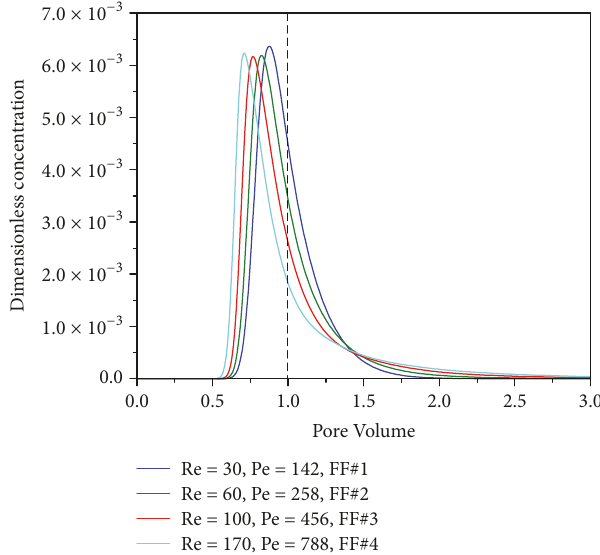
Figure 3: Breakthrough curves of compound A for the nonreaction transport under the different flow fields in the single self-affine fracture with Hurst exponent of